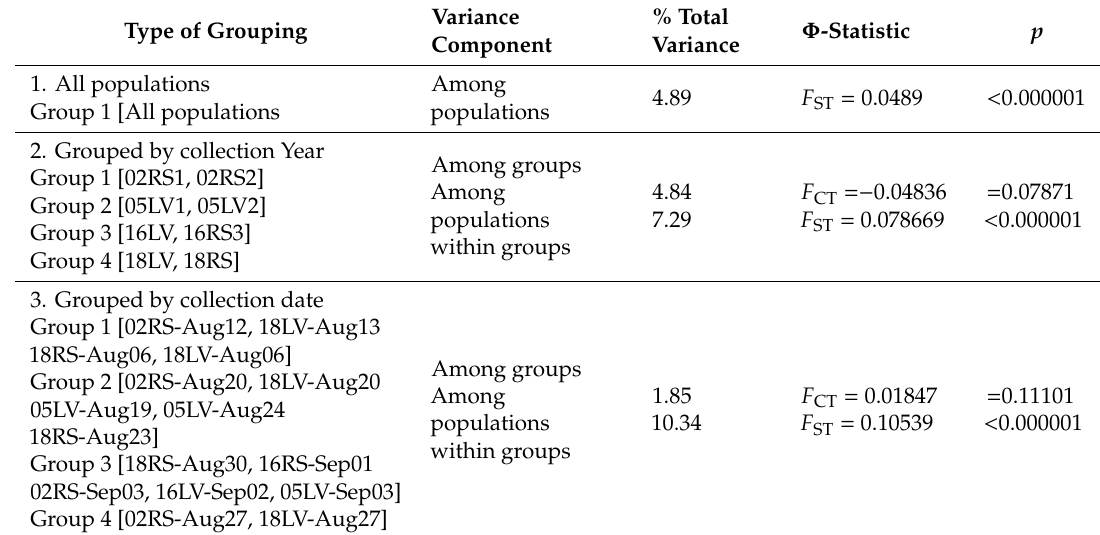
Table 3. The results of analysis of molecular variance (AMOVA) of 16 H. zea collections grouped by various categories to calculate F ST (between populations when there was only one group) or F CT (among groups). Populations grouped together in each analysis are shown within square brackets.